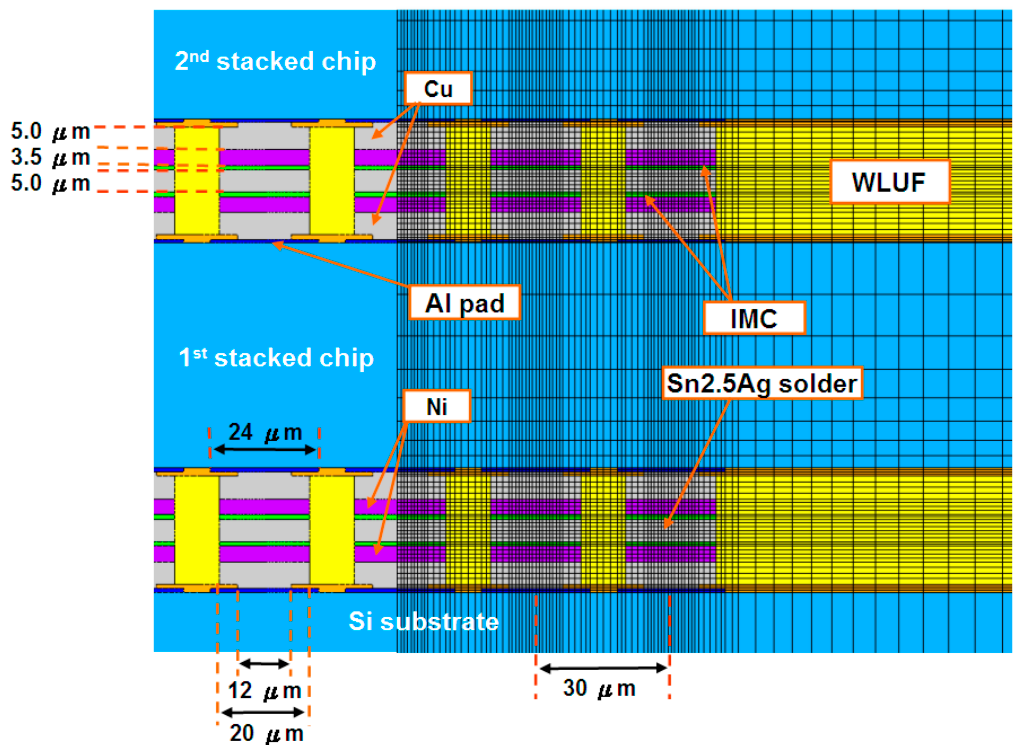
Figure 7. Detailed dimensions, components, and finite element mesh of the μ -bump framework used in the temperature cycling simulation of four-chip stacking, which was assembled through the WLUF thermo-compression procedure; IMC: intermetallic compound.